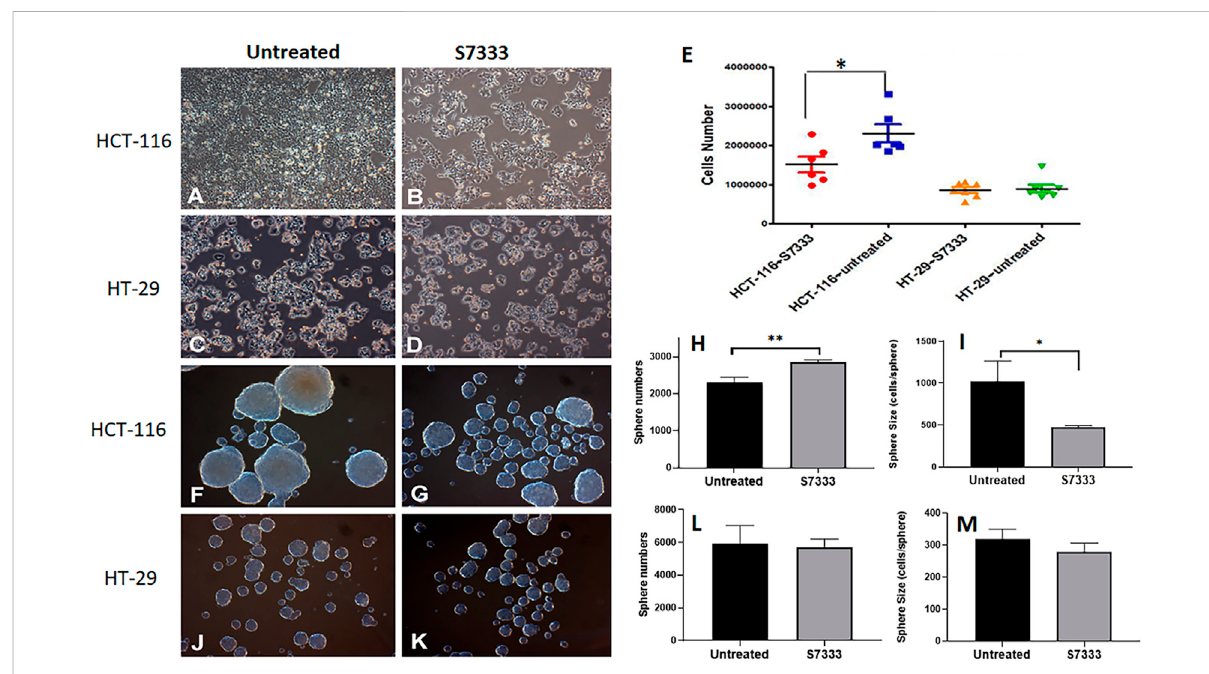
The comparison of cell growth and spheroid formation between HCT-116 andHT-29 cells after S7333treatment.Cell morphology and density changes under light microscope of HCT-116 (A,B) and HT-29 cells (C,D) before and after treatment with S7333 for 72 h at 4 µM. (E) , the comparison oflivecellnumbersbetweenHCT-116andHT-29cellsbeforeandafterthetreatmentwithS7333. (F,G) showthemorphologyandnumbersoftumor spheroidsfromHCT-116cellsbefore (F) andafter (G) treatment.Thenumberofspheroidssigni fi cantly increased (H) whilethesize